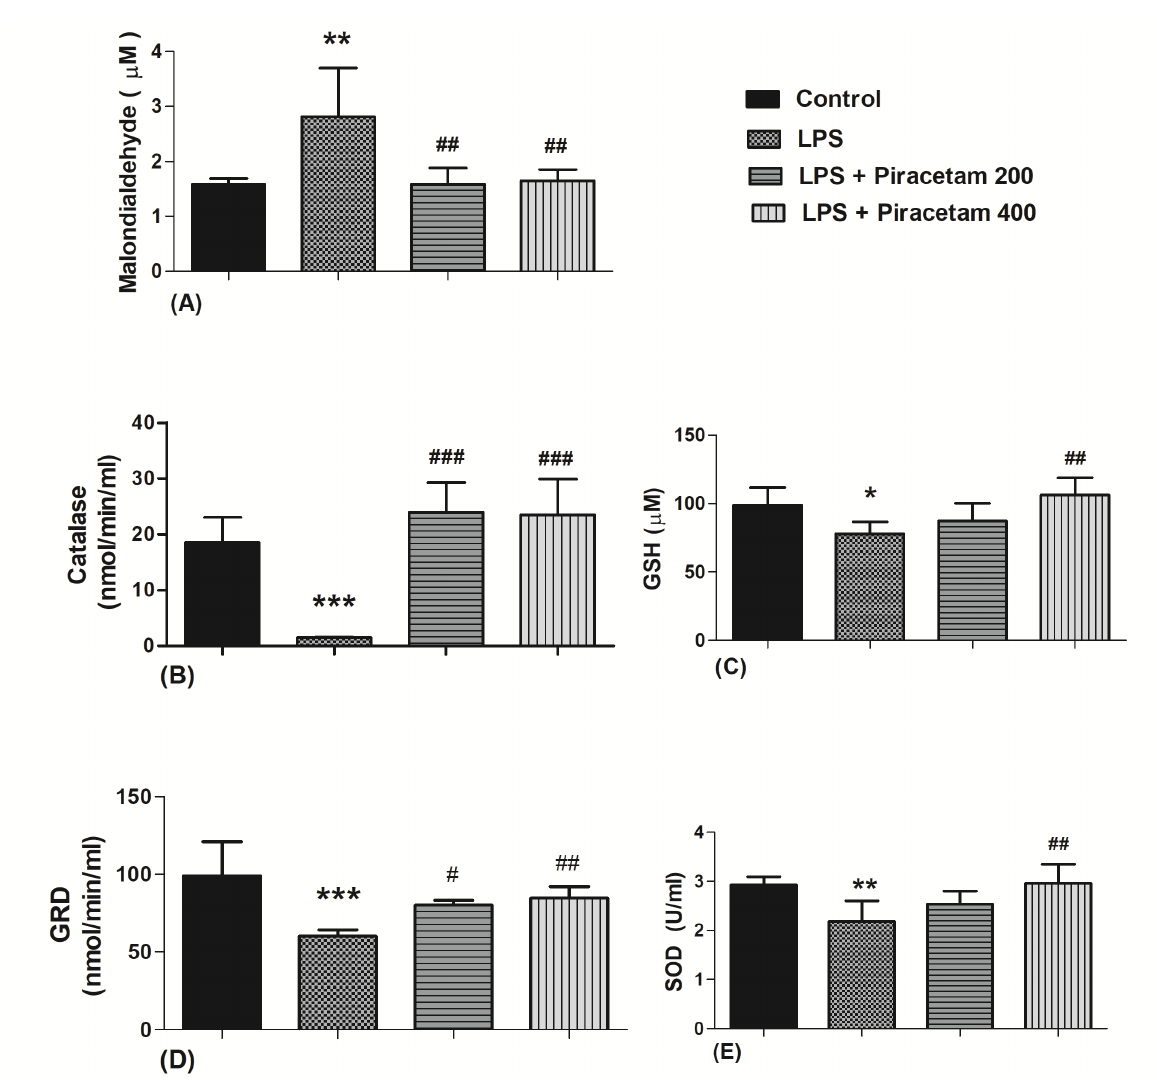
FIGURE 3 - Effect of piracetam on oxidative stress and antioxidants in brains of LPS-induced mice. The antioxidants and oxidative stress were measured with an ELISA kit, which examined: (A) MDA level in brain homogenate that reflected oxidative stress, (B) Catalase activity in brain homogenate, (C) Concentration of reduced glutathione (GSH) in brain homogenate, (D) Glutathione reductase (GRD) activity in brain homogenate, and (E) Superoxide dismutase (SOD) activity in brain homogenate. The values are mean ± SEM (n=6) (*P<0.05, **P<0.01 and ***P<0.001 vs. control group; # P<0.05, ## P<0.01 and ### P<0.001 vs. LPS-induced